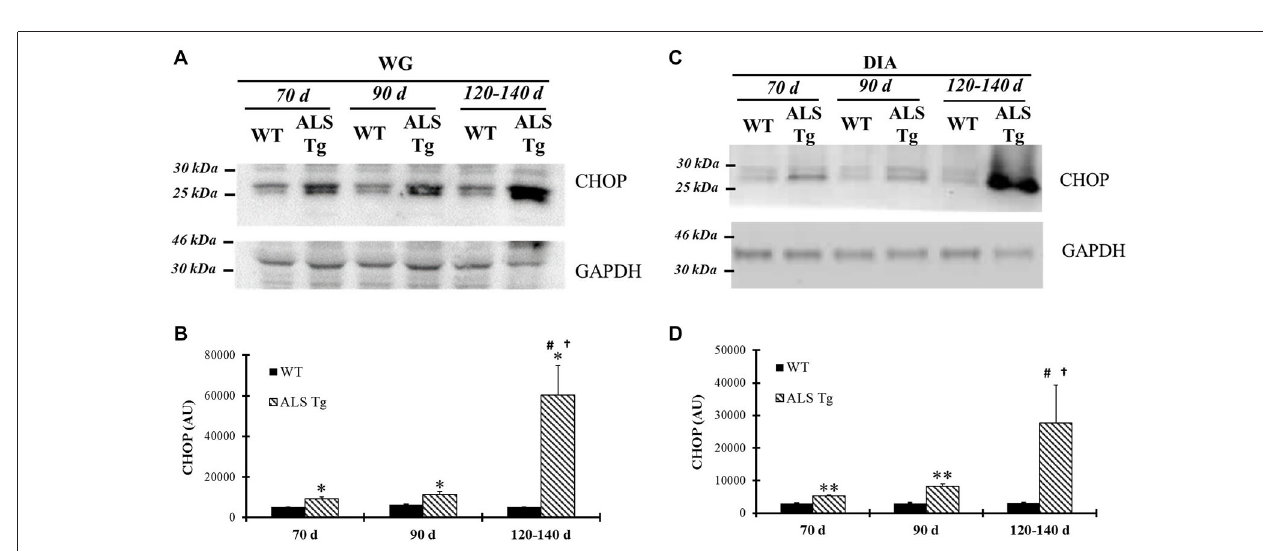
FIGURE 5 | Grp78/BiP protein identification and quantitation using label-free spectral counting-based mass spectrometry . (A) Workflow of label-free spectral counting-based protein quantitative analysis using LC-MS/MS. Protein samples were separated using SDS-polyacrylamide gel electrophoresis (PAGE) and gel pieces excised at ∼ 80 kDa for the purpose of in-gel trypsin digestion and LC-MS/MS analysis. Protein quantitative data analysis was conducted using spectral counting and interpreted by normalized